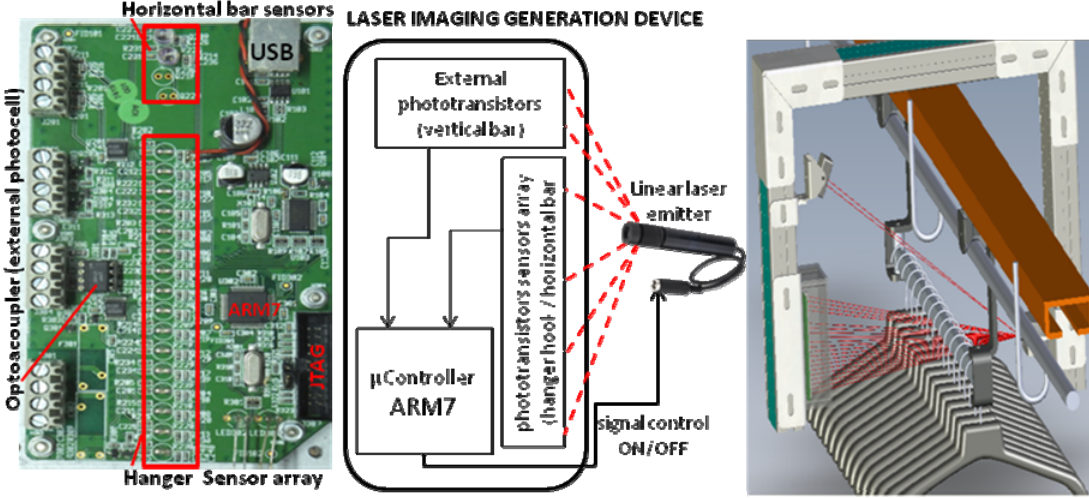
Figure 5. Laser imaging Generation